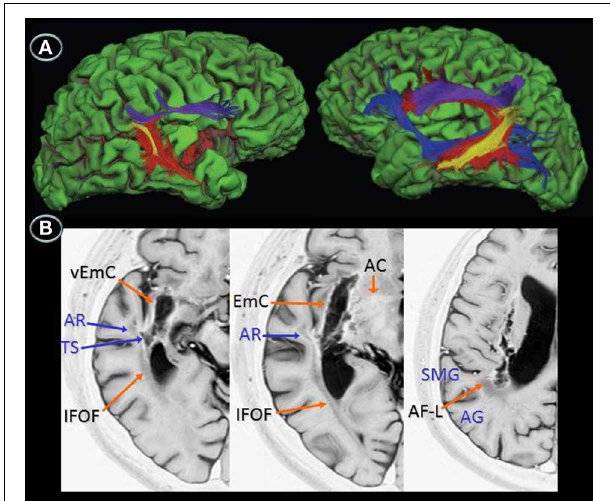
FIGURE 2 | Diffusion tensor imaging (3T MRI) of patient JAM. (A) Uninflated surface of the cerebral hemispheres (FreeSurfer reconstruction) depicting gyri in green and sulci in red. The right image shows a small cortical component of the haemorrhage (red) involving the right anterior insula and superior temporal gyrus. The diffusion tensor imaging reconstruction of the arcuate fasciculus and inferior fronto-occipital fasciculus shows (left image) damage to the right long direct segment of the arcuate fasciculus (red) and inferior fronto-occipital fasciculus (blue) with relative sparing of short and long fibers of the anterior indirect segment (purple) and posterior segments (yellow), whereas the right image shows fully developed left perisylvian white matter pathways. (B) Anatomical axial MRI section (Short T1 Inversion Recovery—STIR—sequence) show the right striatocapsular lesion and perinecrotic tissue with degeneration of several white matter tracts (orange and blue arrows). AR indicates, auditory radiations; TS, temporal stem; SMG, supramarginal gyrus; AG, angular gyrus; EmC, extreme capsulae; vEmC, extreme capsulae; IFOF, inferior fronto-occipital fasciculus; AC, anterior commissure; AF-L, arcuate fasciculus-long